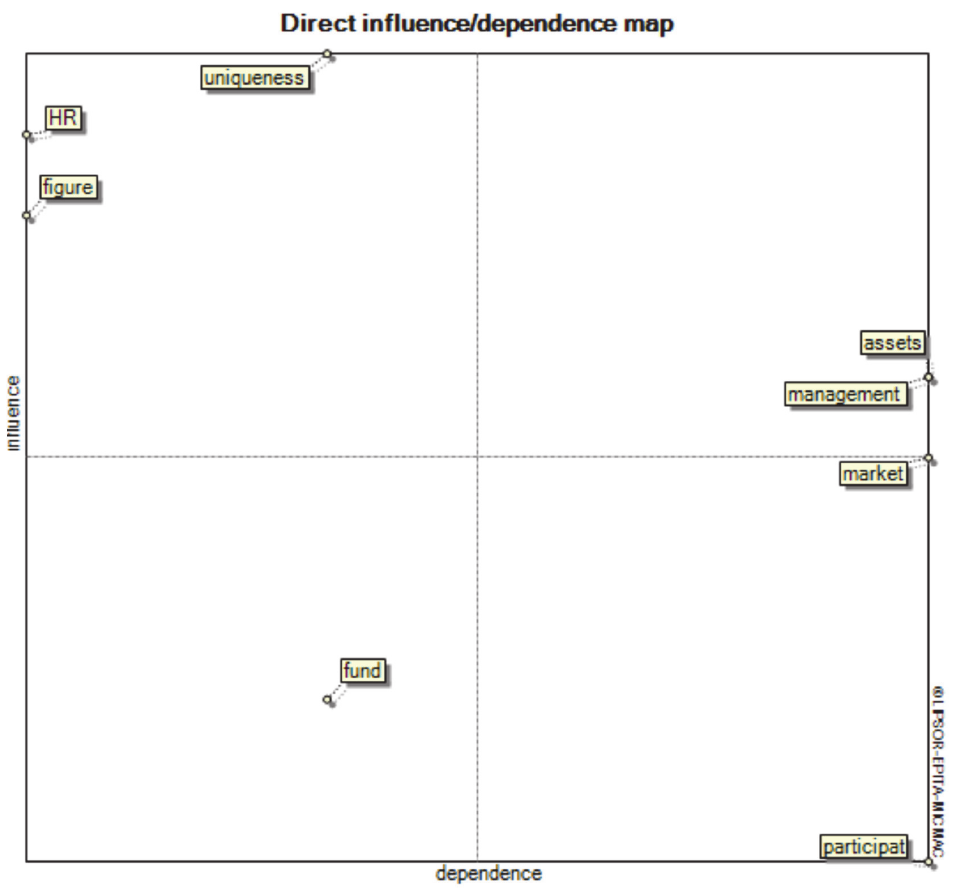
Fig. 4. Map of Sustainability Variables in the Bongkasa Pertiwi Tourism Village According to Influence and